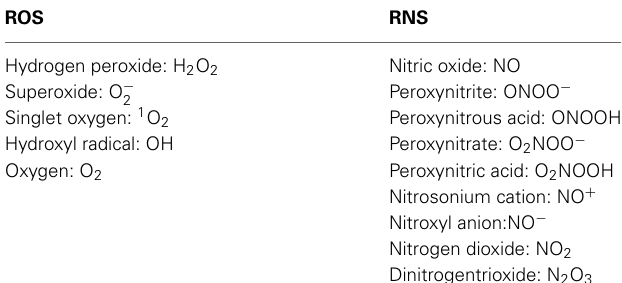
Table 3 | Reaction stoichiometry between ROS and RNS.